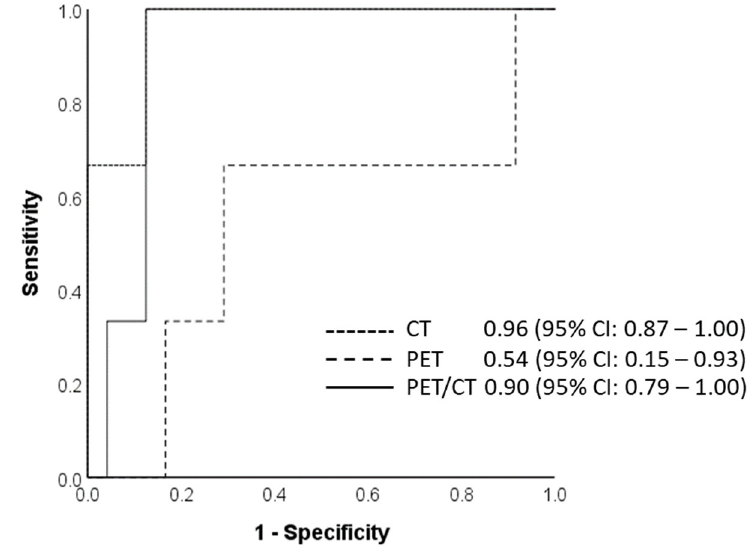
Figure 3. Area under the curve for the final radiomics model to predict tumor category on CT, PET, and PET/CT test datasets using five radiomics features, calculated at 0.96, 0.54, and 0.90, respectively; 95% confidence intervals are presented within parentheses.